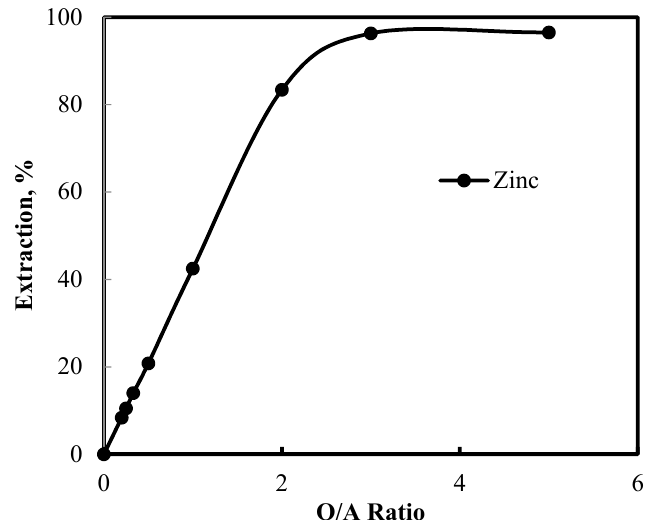
Figure 6. Effect of phase volume ratio (O/A) on the extraction of zinc from purified leach solution.